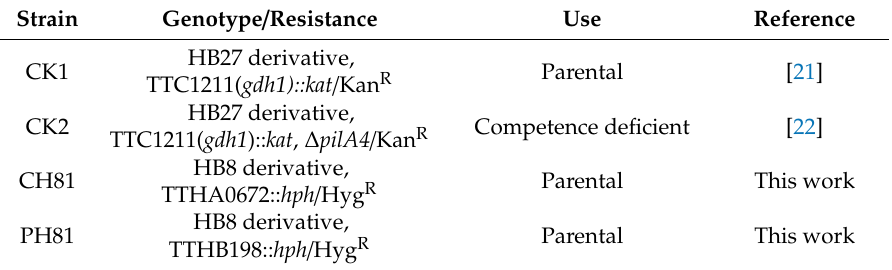
Table 1. Strains of T. thermophilus used in this